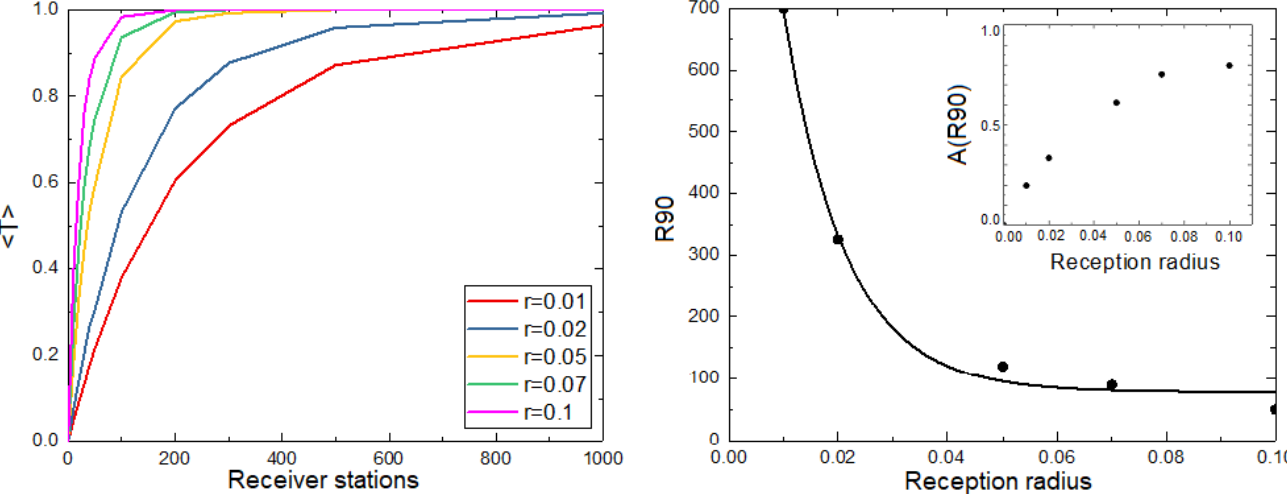
Figure 3. ( Left ) Average number of transmitted packages per unit of time and animal ( (cid:104) T (cid:105) ) vs. the number of receiver stations distributed in the space for a fixed value of a and different values of the reception radius r . Curves for different values of r are included. ( Right ) Number of receiver stations needed to receive an average of at least 90% of the total packages R 90 as a function of r . The exponential fit of the form y = yo + Ae ( − ( x − x 0 ) / t 1 ) is included. The inset shows the fraction of the covered area for which 90% of the packages are transmitted as a function of the reception radius. For all graphs we show results averaged over 100 realizations. 20,000 time steps were considered, N = 500, v = 0.001, a =